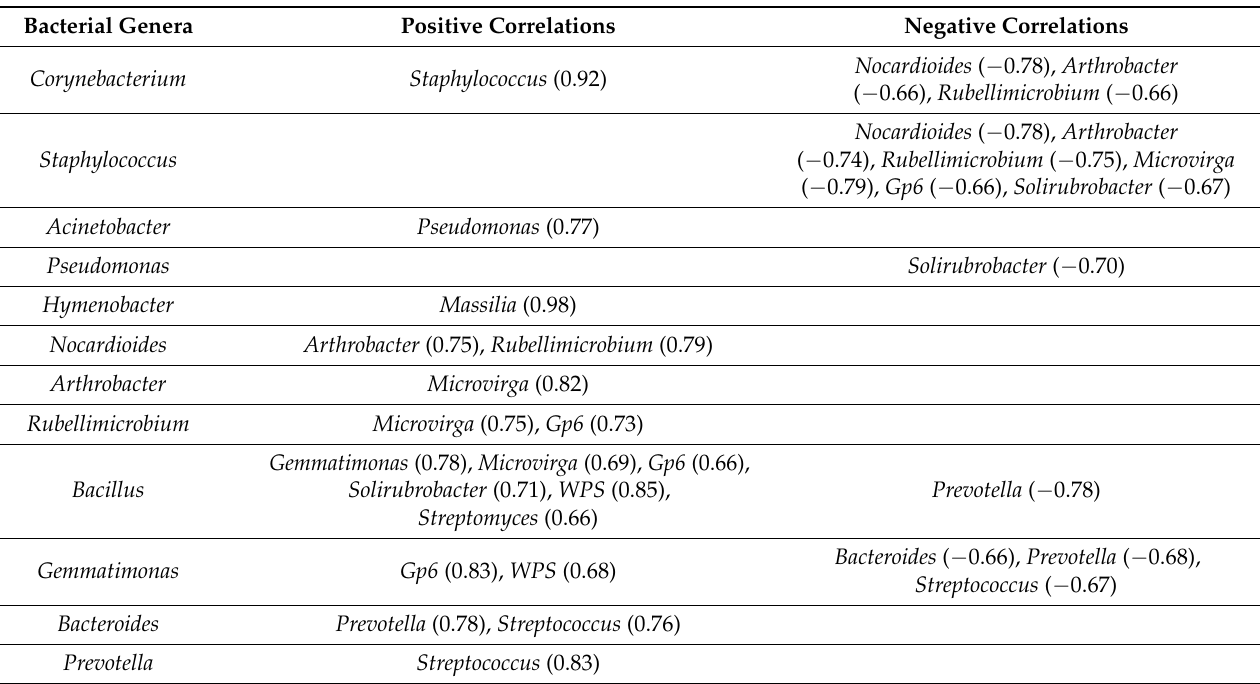
Table 2. ρ metrics values among the selected 25 genera. Only significant positive ( ρ values > 0.65) and negative ( ρ values < − 0.65) values are reported in the table. WPS in the “Bacterial Genera” column represents WPS Unclassified1_genera_incertae_sedis